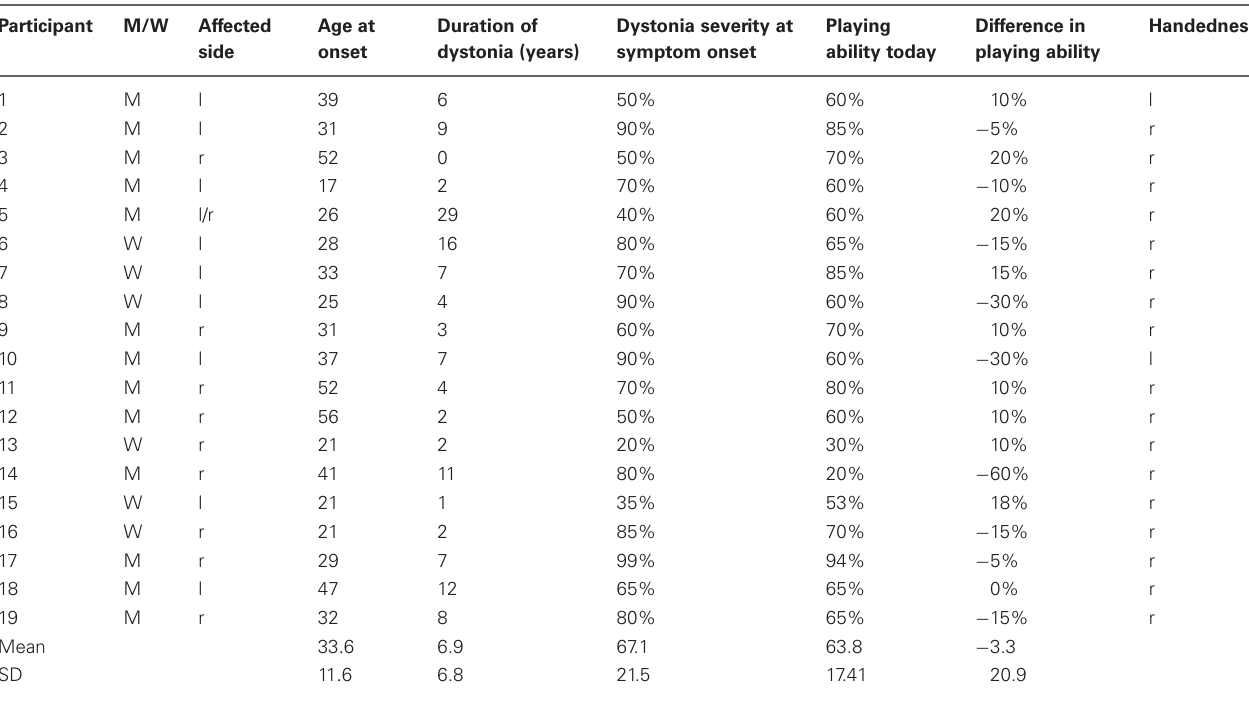
Table 1 | Epidemiological data of the